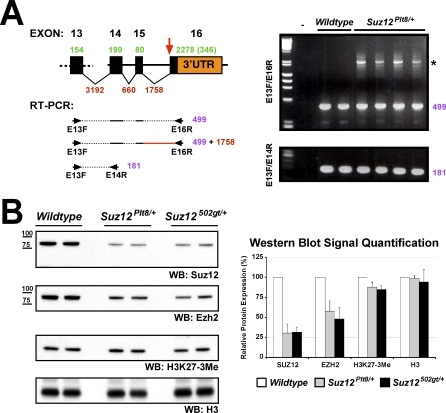
The Plt8 Mutation Disrupts Production of the Suz12 mRNA and Protein(A) A schematic representation of part of the Suz12 locus is shown to detail the intron and exon structure (at left). Primers were designed to flank the site of the mutation (red arrow), and RT-PCR was performed on cDNA prepared from bone marrow. An aberrantly spliced product (asterisk) was identified in cDNA prepared from Suz12Plt8/+ mice that was not present in wild type.(B) Protein lysates were prepared from sex-matched embryonic day 12.5 (E12.5) embryos for analysis by Western blotting, which revealed that Suz12 and Ezh2 protein levels were reduced in Suz12Plt8/+ embryos. Suz12 protein levels appeared equivalent in Suz12Plt8/+ embryos and embryos heterozygous for the genetrap allele (Suz12502gt/+). Equivalent amounts of protein were run in each lane (20 μg), and histone H3 was used to verify equal loading. Western blot signal intensity was quantified using a densitometer; results represent the average of two independent experiments expressed as protein expression in Suz12Plt8/+ (gray) and Suz12502gt/+ (black) embryos relative to wild type (white, 100%).